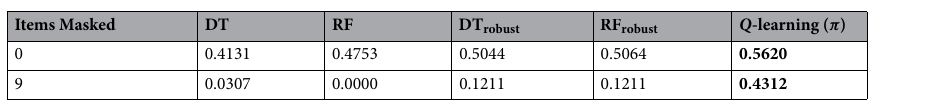
Table 3. F1-Score initially when all data is available, subsequently when only one feature is available.